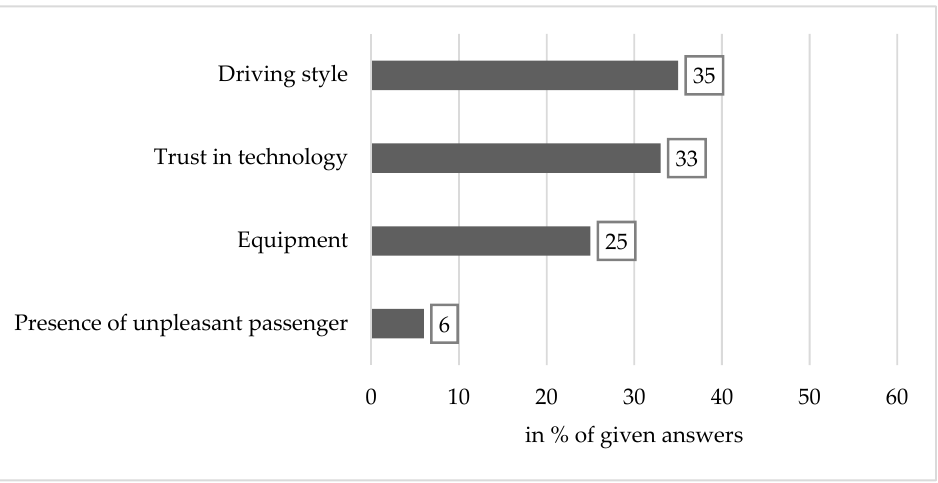
Figure 3. Factors influencing perceived safety (“What has influenced your feeling of safety?”).